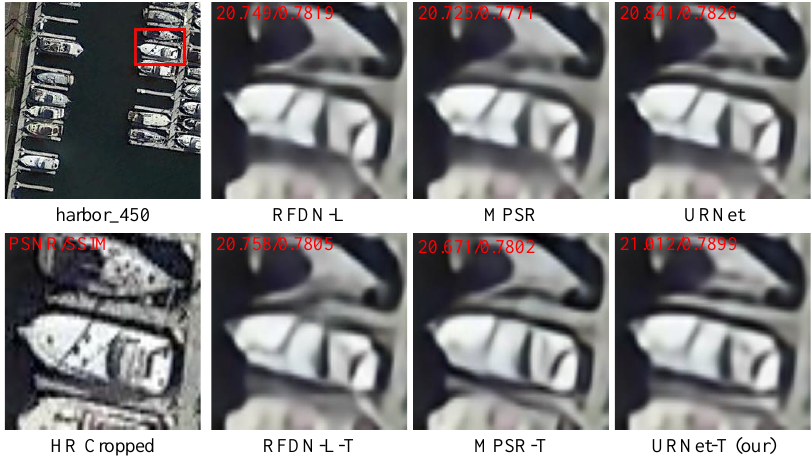
Figure 11. Comparison of reconstructed HR images of “harbor_450” obtained from RESISCTest dataset with 256 × 256 pixel images using different methods with a scale factor of ×